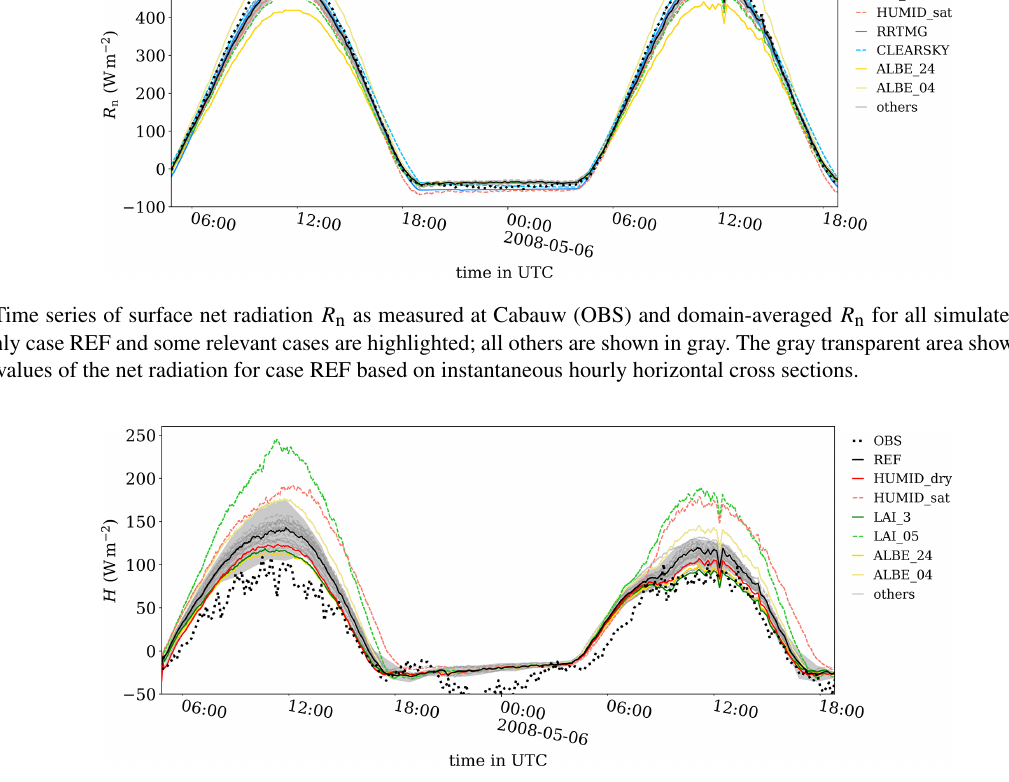
Figure 4. Time series of surface sensible heat flux H as measured at Cabauw (OBS) and domain-averaged H for all simulated cases listed in Table 5. Only case REF and some relevant cases are highlighted; all others are shown in gray. The gray transparent area shows minimum and maximum values of the sensible heat flux for case REF based on instantaneous hourly horizontal cross